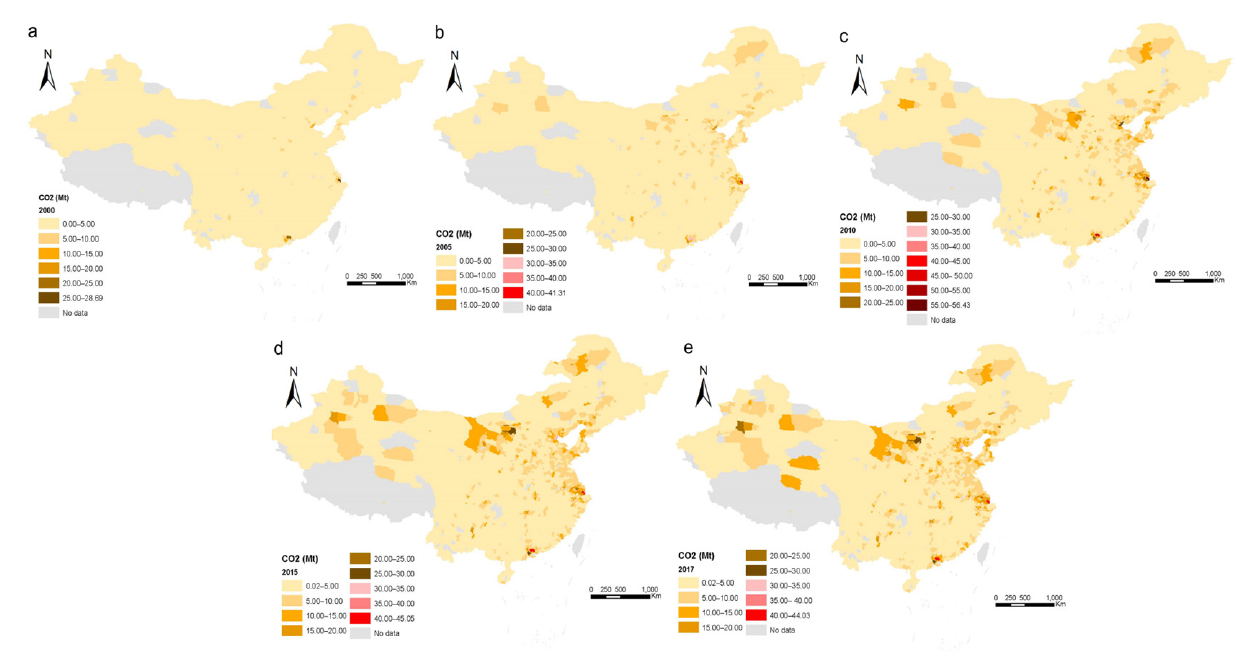
Figure 5. Spatio ‐ temporal pattern of CO 2 emissions in China in ( a ) 2000, ( b ) 2005, ( c ) 2010, ( d ) 2015, and ( e ) 2017.